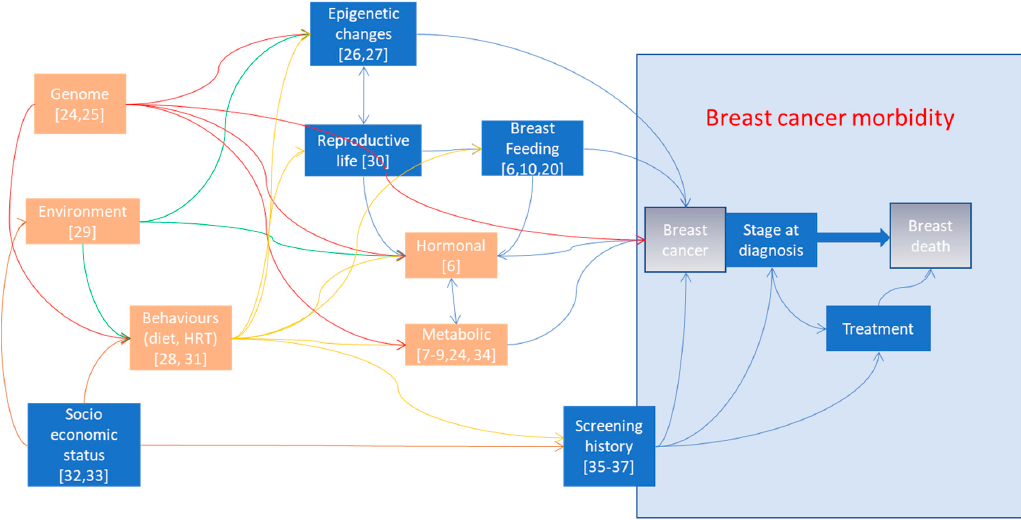
Figure 2. Graphic representation of the determinants of breast cancer mortality. Orange boxes represent risk factors not assessed in the study. Blue boxes represent risk factor assessed in the study.